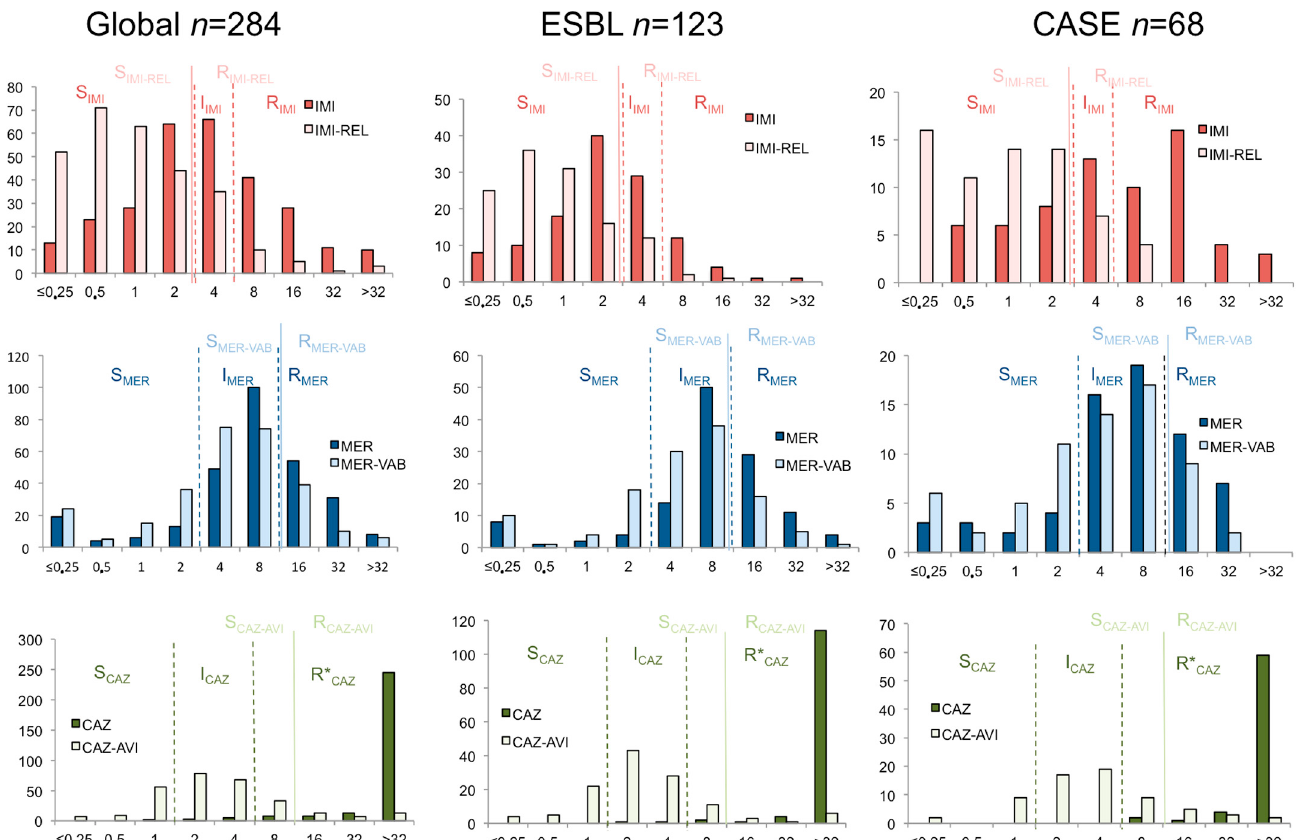
Figure 1. MIC distributions of imipenem. imipenem/relebactam meropenem, meropenem/vaborbactam, ceftazidime and ceftazidime/avibactam on a collection of 284 carbapenem-resistant non-carbapenemase-producing Enterobacterales. The global collection ( n = 284) of CRE non-CPE was divided by resistance mechanisms in three categories (Global) ( n = 284), ESBL-producing isolates (ESBL) ( n = 123) and deregulated cephalosporinases (CASE) ( n = 68). EUCAST breakpoints are indicated by dashed lines ( β -lactam alone) and continuous lines ( β -lactam/inhibitor combination) dashed lines.